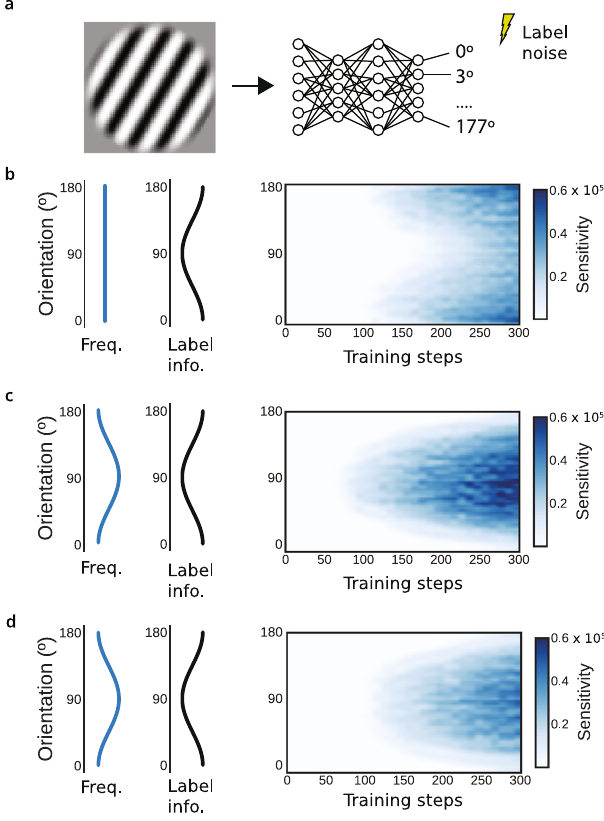
Fig. 6 | Dissociating the effect of frequency and information in supervised learning tasks. a We trained 3-layer nonlinear neural networks to classify the orientation of sinusoidal gratings into 3 ∘ bins, varying either input frequency or output noise. b We controlled the informativeness of input orientations by injecting noise into the labels as a function of orientation (speci fi cally, the binary labels are multiplied by a Bernoulli dropout with a rate that depends on orienta- tion). The sensitivity of the fi rst layer to input orientation is shown over learning. With uniform statistics, the more informative features are preferentially learned. c The effect of varying input frequency without applying label noise. In this case, the more frequent features are preferentially learned. d We then balanced noise and frequency such that the total information in the input dataset about each output label is uniform (see Methods). Learning with gradient descent still prefers common